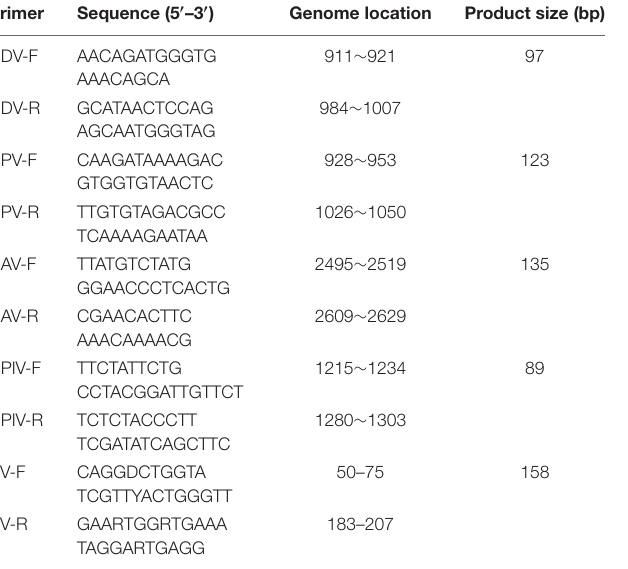
Frontiers in Microbiology |